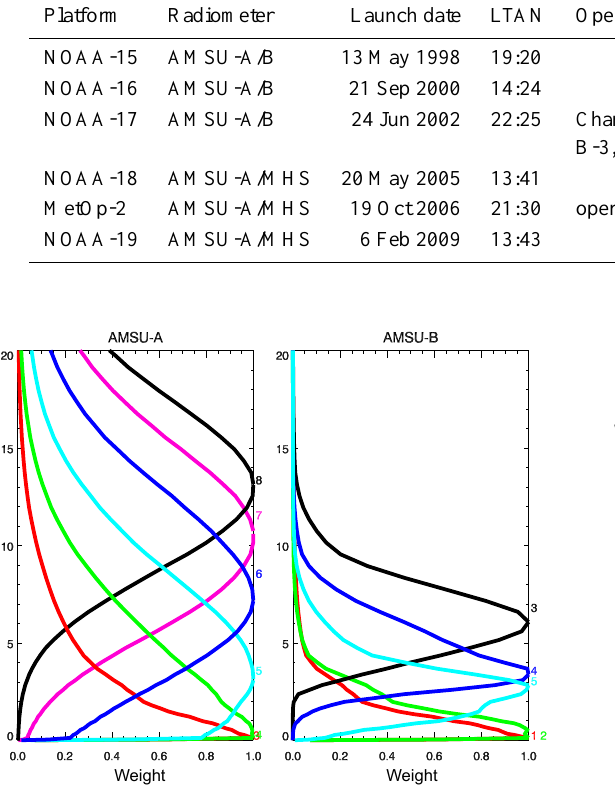
Fig. 3. Normalized weighting functions for (a) the AMSU-A temperature channels sounding in the troposphere (3–8) and (b) AMSU-B channels at nadir, for a Mediterranean atmospheric profile. Note that Channels 2 and 5 differ between AMSU-B and MHS, but their weighting function is very close, so that only AMSU-B weighting functions are